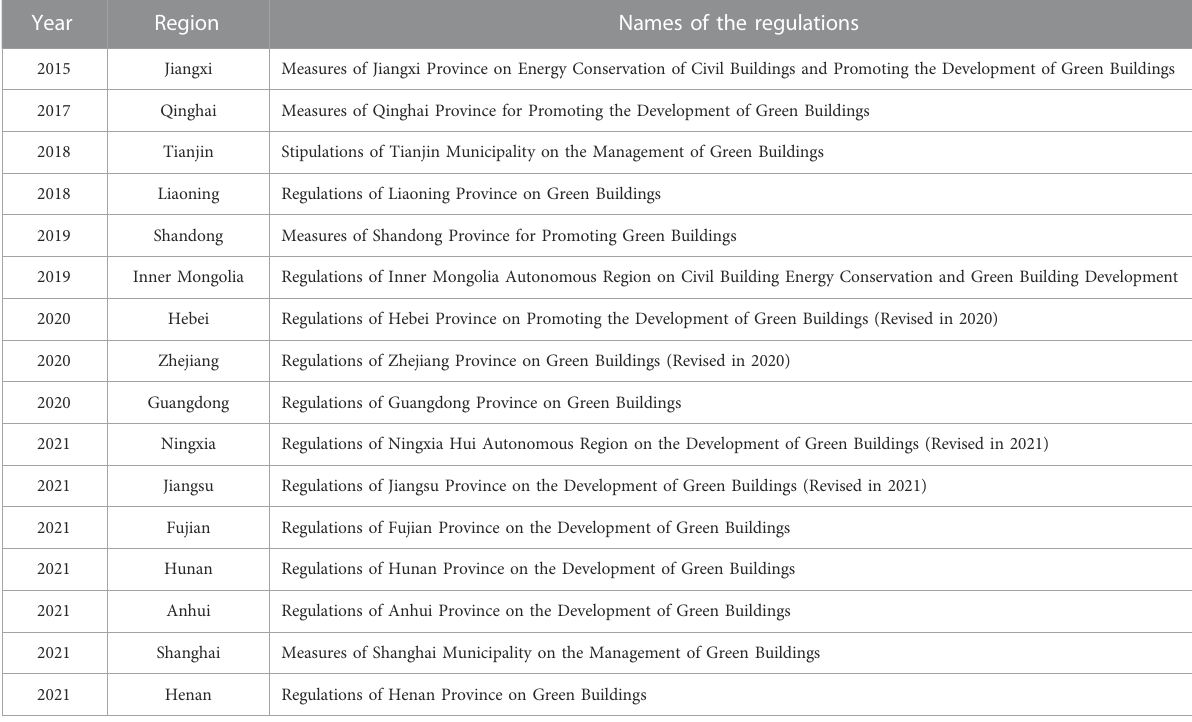
TABLE 2 Provincial regulations of green buildings in China.